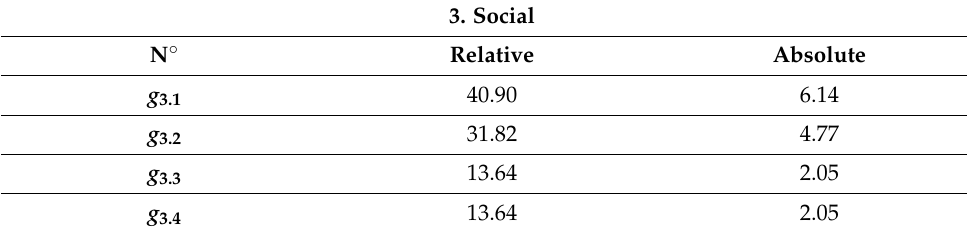
Table 8. Weighting of the social